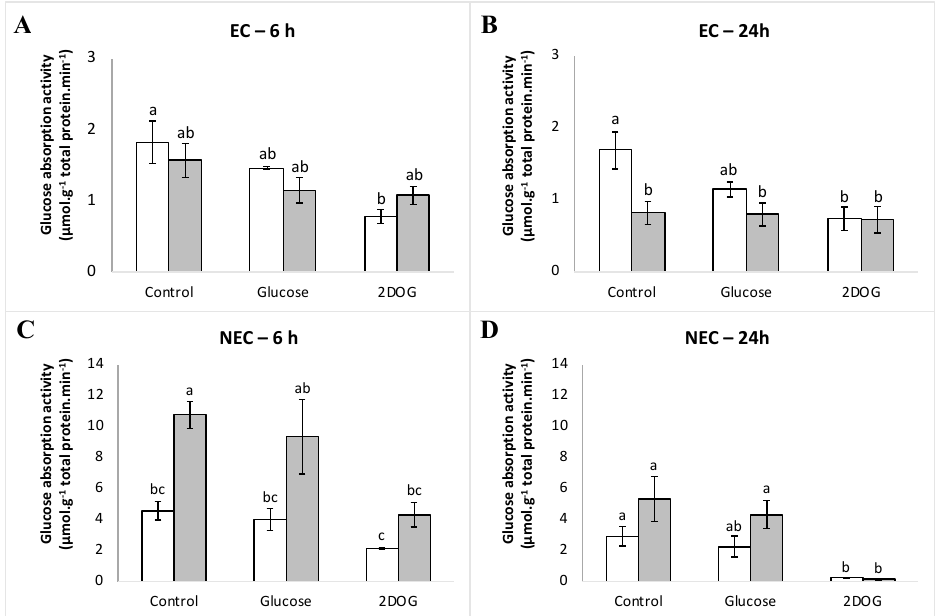
Figure 14. ( A – D ) Glucose absorption activity in embryogenic cells (EC) and non-embryogenic (NEC) WT and VvMSA-RNAi cells. □ -WT; ■ -VvMSA - RNAi. The embryogenic cells and the non-embryogenic cells were collected after 8 days of subculture and incubated for an additional 24 h in their respective minimal media, i.e., GM° minimal (EC) and Gb minimal (NEC). Sugar effectors were added afterwards and the treatment of EC was extended for 6 h, while that of NEC for 24 h. 14 C-glucose uptake was measured at the 20th minute after the effector supply. Three independent biological repetitions were carried out for each of the studied conditions, with at least three technical replicates per biological repetition. The letters denote the groups that were found significantly different by ANOVA and Tukey’s HSD test ( p < 0.05).